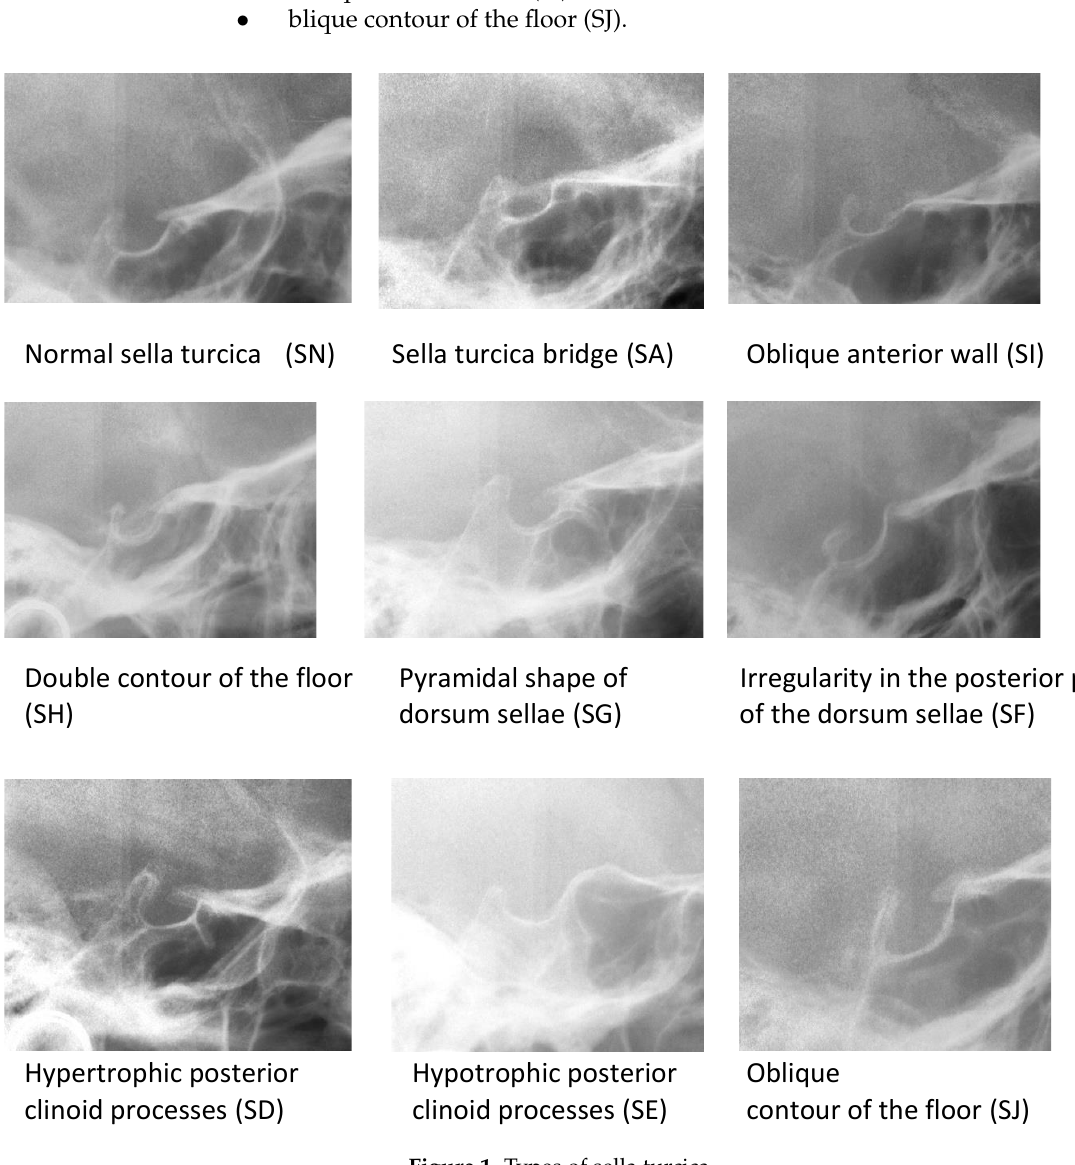
Figure 1. Types of sella turcica.